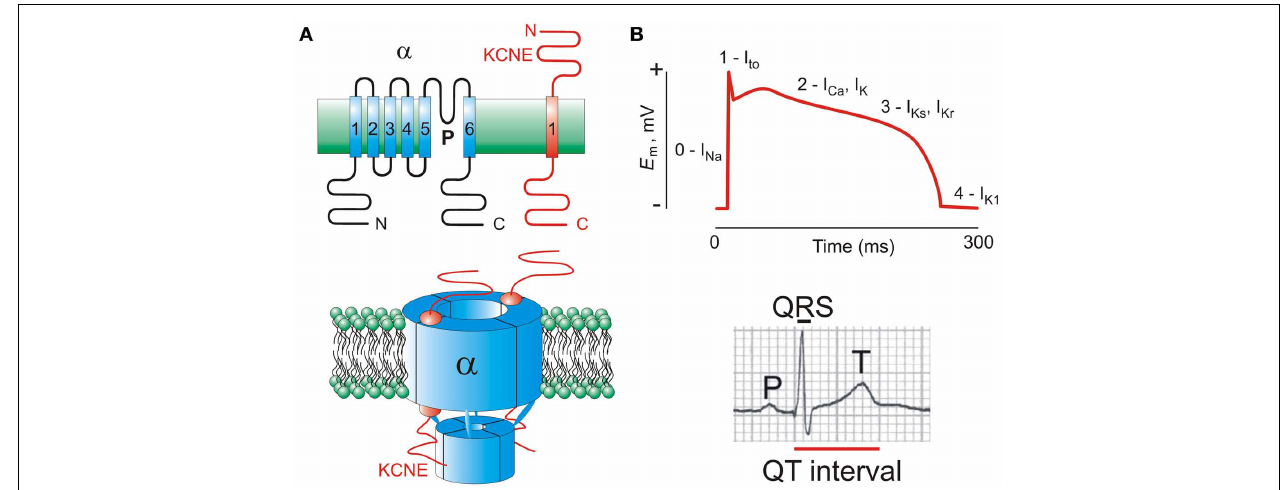
FIGURE 1 | KCNE subunits and the ventricular myocyte action potential. (A) Upper , transmembrane topology of Kv α and KCNE subunits with transmembrane segments numbered; lower , one suggested stoichiometry of a KCNE-containing Kv channel complex.